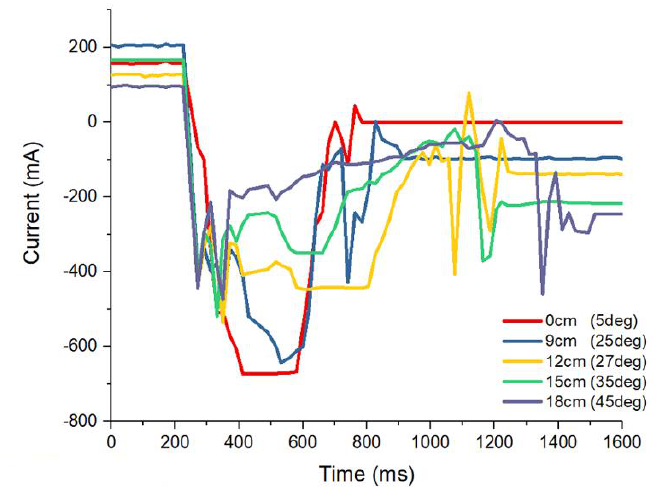
Figure 6. Graph of the current with various lengths of DAMs.